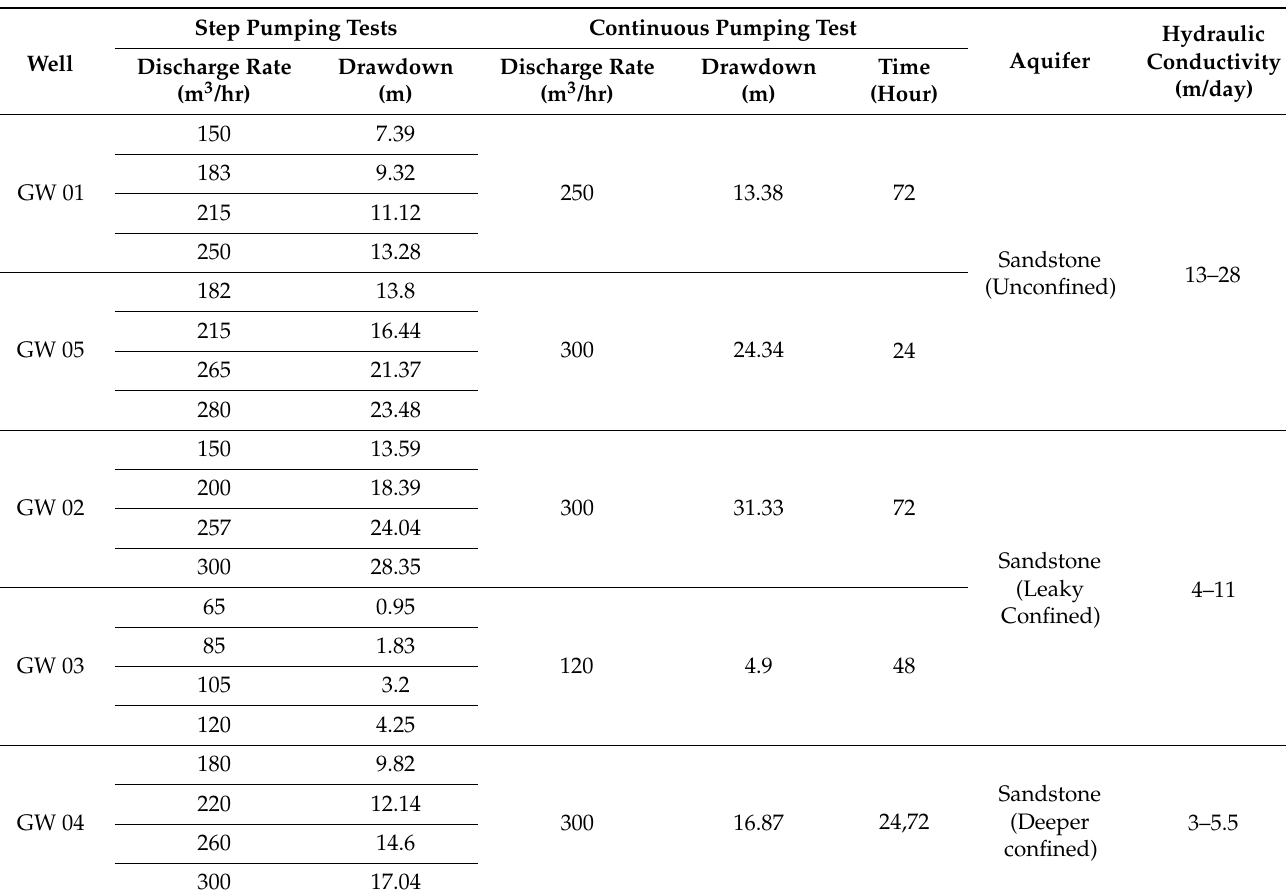
Table 1. Pumping test field data for three aquifers.